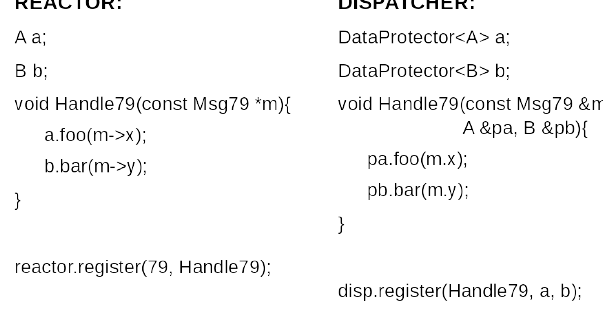
Figure 7. Typical Usage of Dispatcher vs.